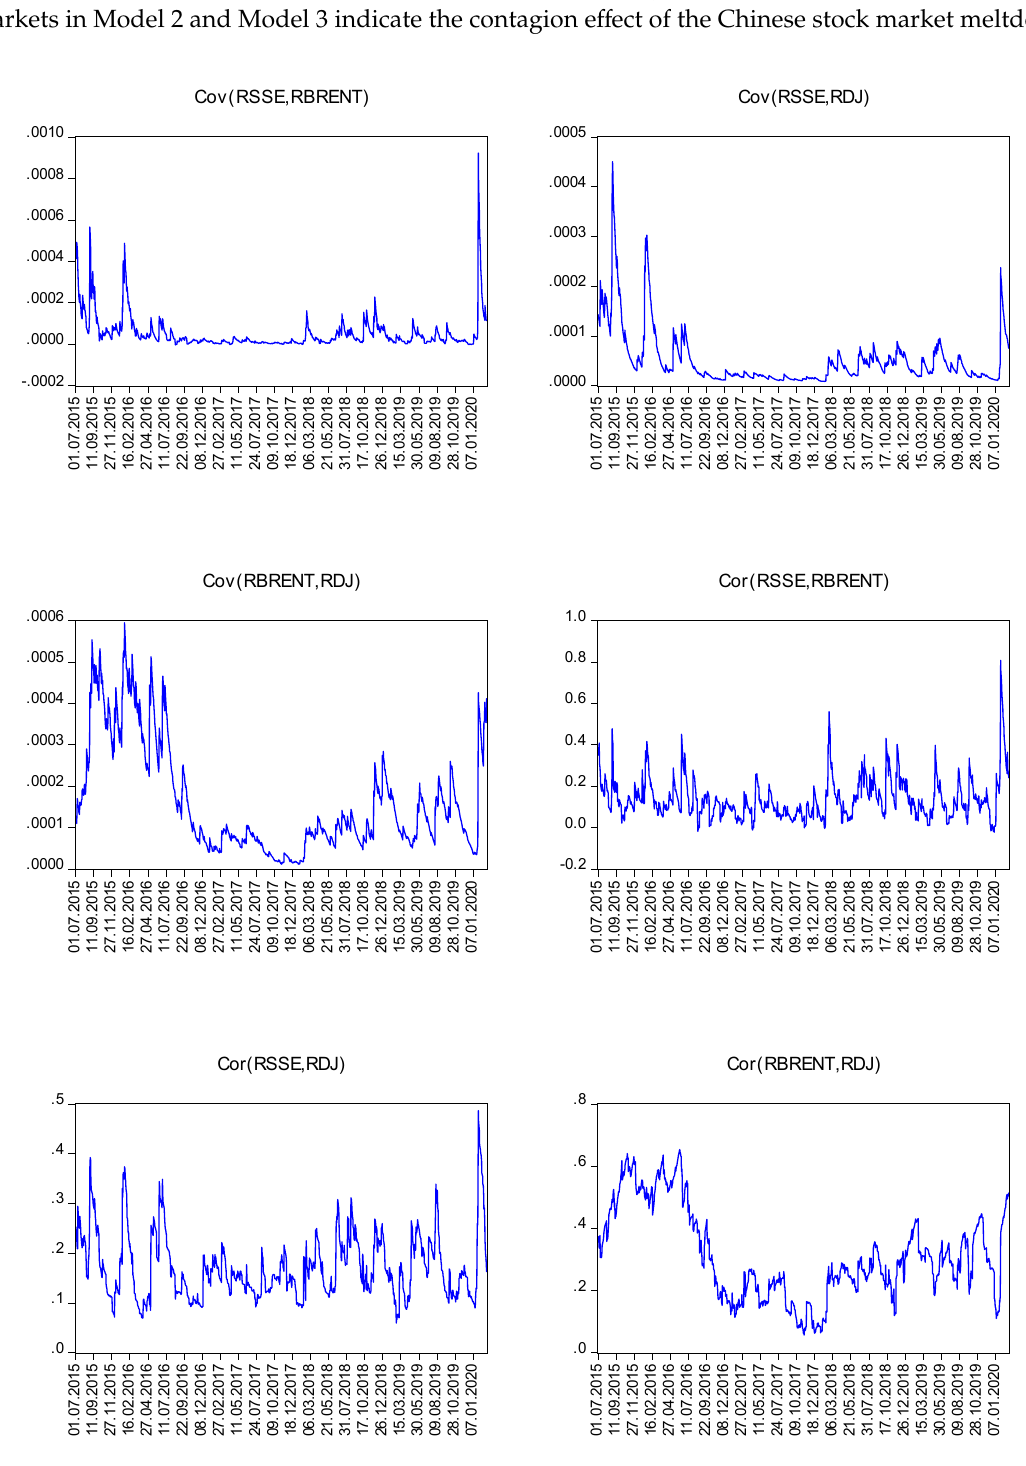
Figure 3. Covariance and correlations for Model 1.